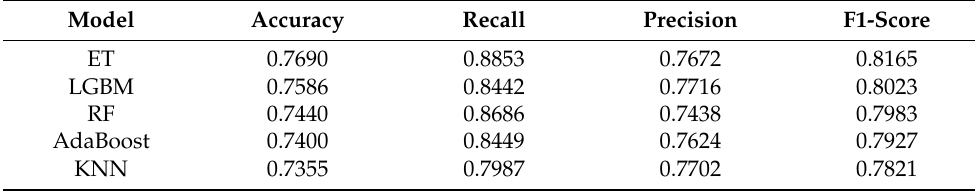
Table 3. Performance of the hyperparameter fine-tuned models.